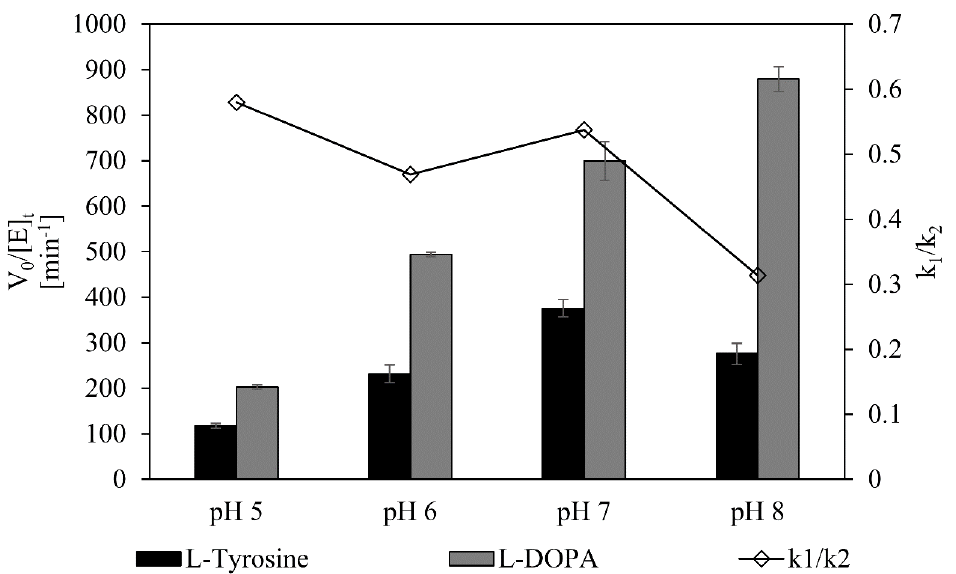
Figure 4. Monophenolase versus diphenolase activity assay of Bm Ty in the various pH. 1000 μM of L-tyrosine (black bar) and L-DOPA (gray bar) were used as initial substrates to measure monophenolase (tyrosine hydroxylation activity) and diphenolase activity (quinone formation activity) of Bm Ty, respectively.